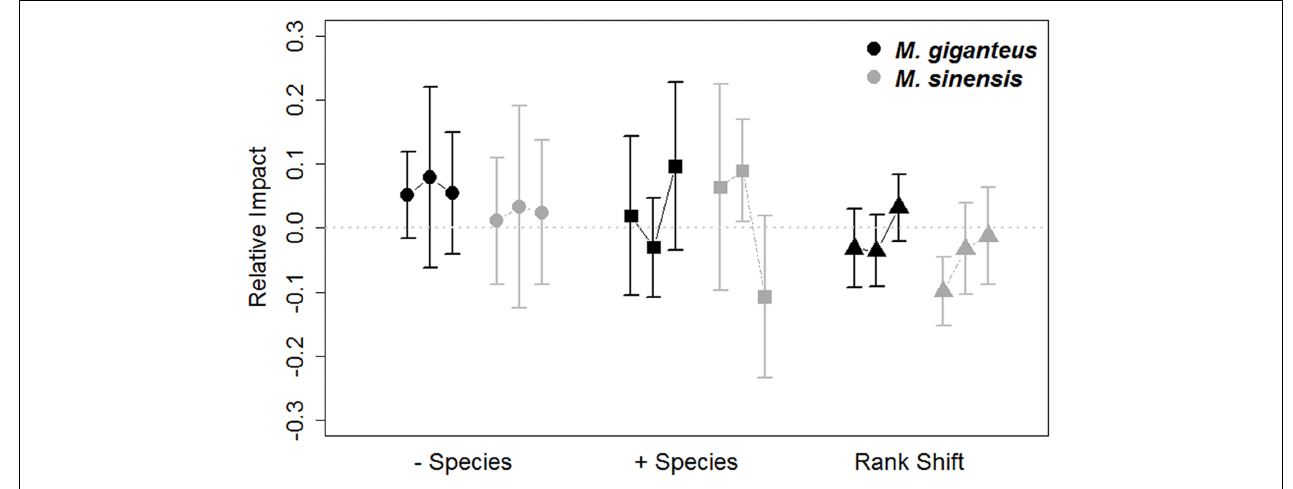
FIGURE 4 | Relative impacts (RI, Mean ± SE) on species turnover and species ranks in M. giganteus (black) and M. sinensis (gray) plots each year from 2011 to 2014. The values for each of the three consecutive year-to-year transitions are connected by lines for each species. The gray dotted line indicates RI value of 0, indicating no impact. Positive RI values indicate greater declines in measured variables relative to gain and can be interpreted as negative associations with Miscanthus addition. Species turnover differed from year-to-year [+ species (appearances) = triangles, – species (disappearances) = circles], but mean shifts in species rank (squares) did not. Miscanthus introduction did not influence these community metrics, regardless of species.